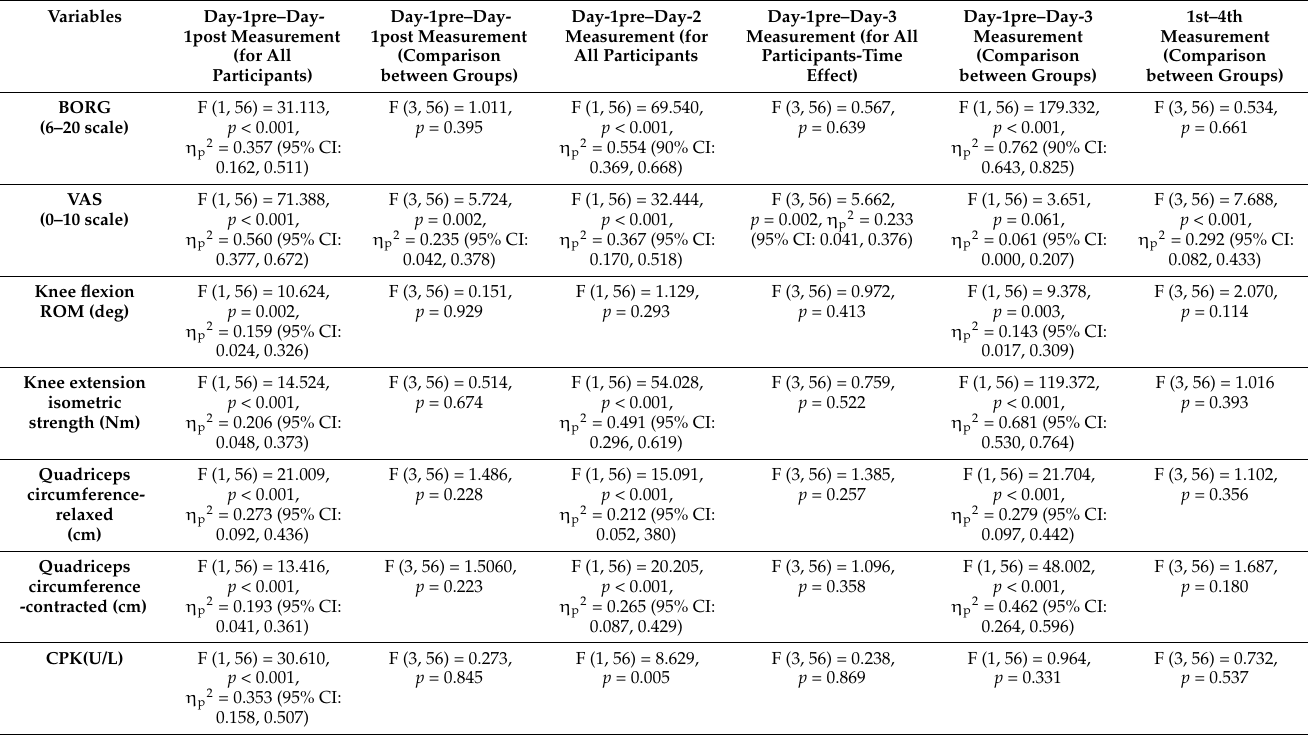
Table 2. Test for statistically significant change of research variables by stage and therapeutic intervention.